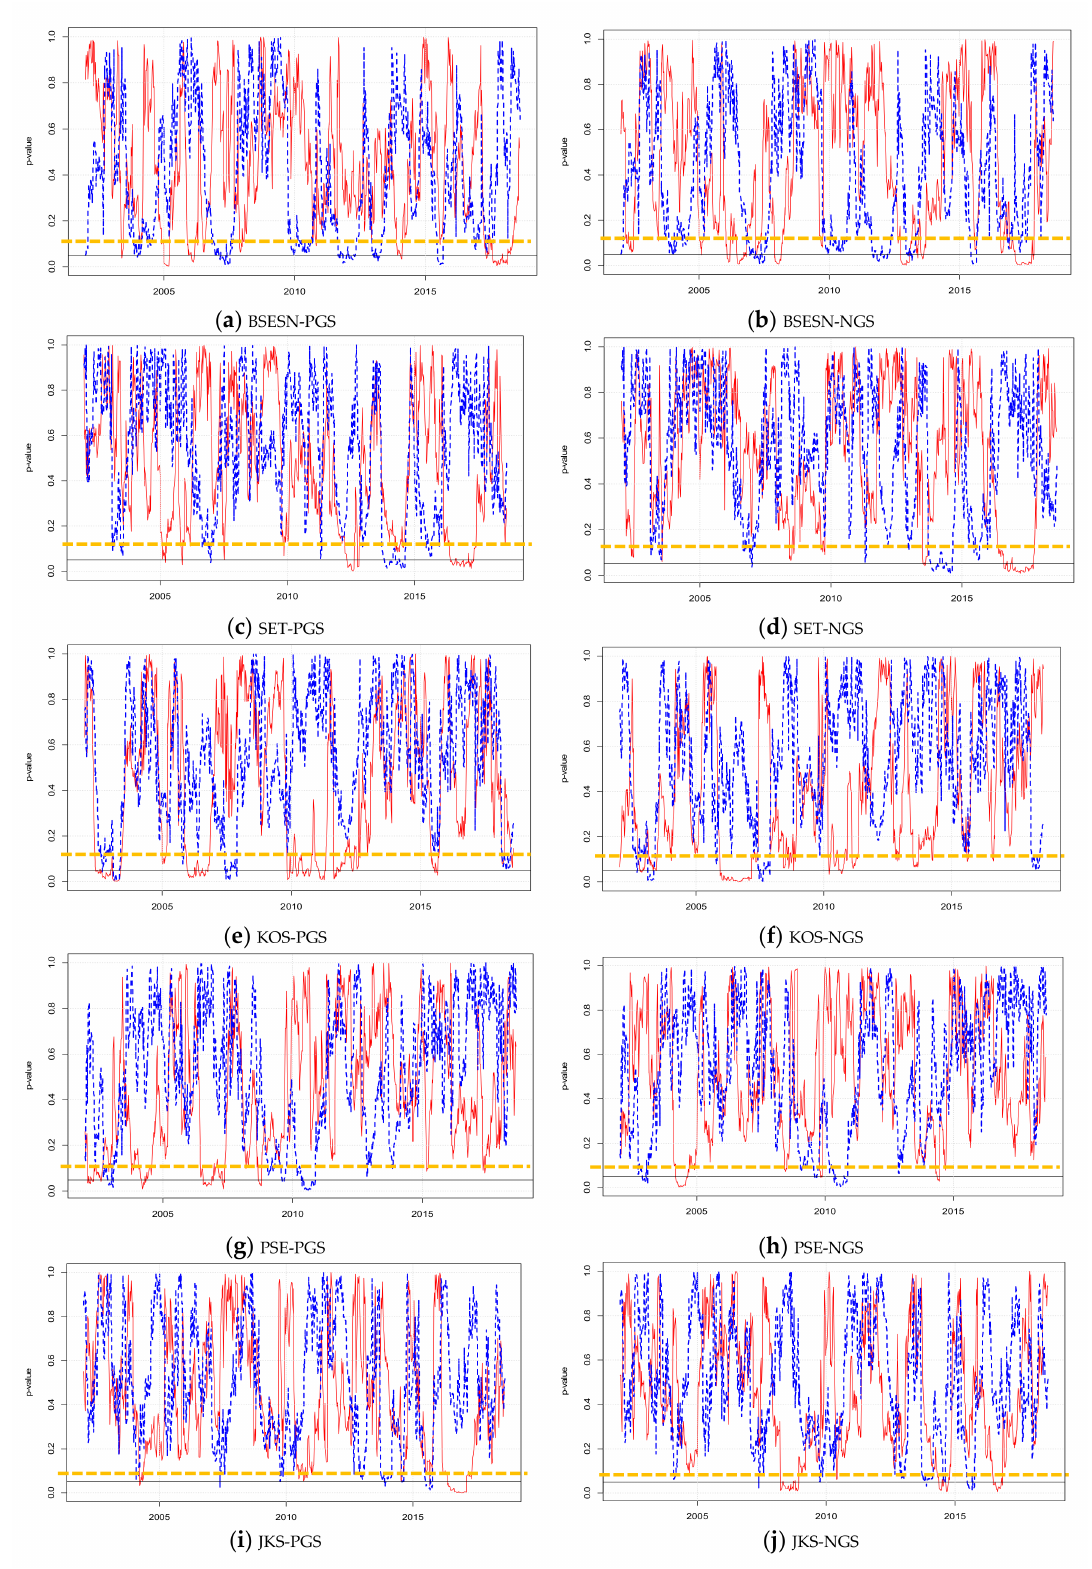
Figure 1. Rolling window bootstrapped p -values of LR test statistic testing of 10 pairs: BSESN-PGS, SET-PGS, KOS-PGS, PSE-PGS, JKS-PGS, BSESN-NGS, SET-NGS, KOS-NGS, PSE-NGS, and